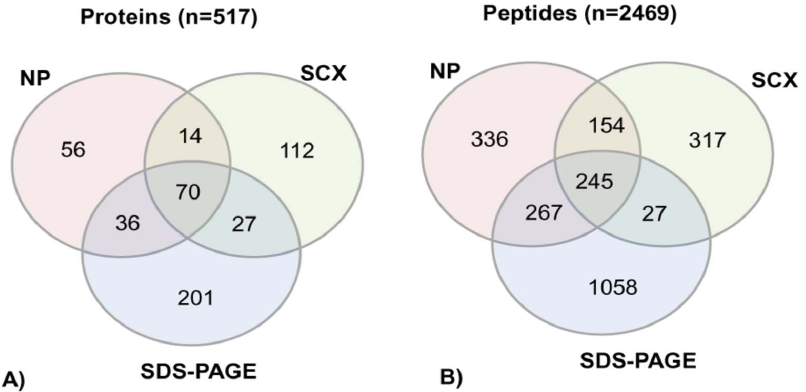
Figure 4. Venn diagram showing consensus of unique proteins and peptides identified in three different workflows. A total of 70 proteins (A) and 245 peptides (B) were identified in all the three workflows. NP- No prefractionation; SCX- Strong cation exchange chromatography; SDS-PAGE- sodium dodecyl sulfate polyacrylamide gel electrophoresis.